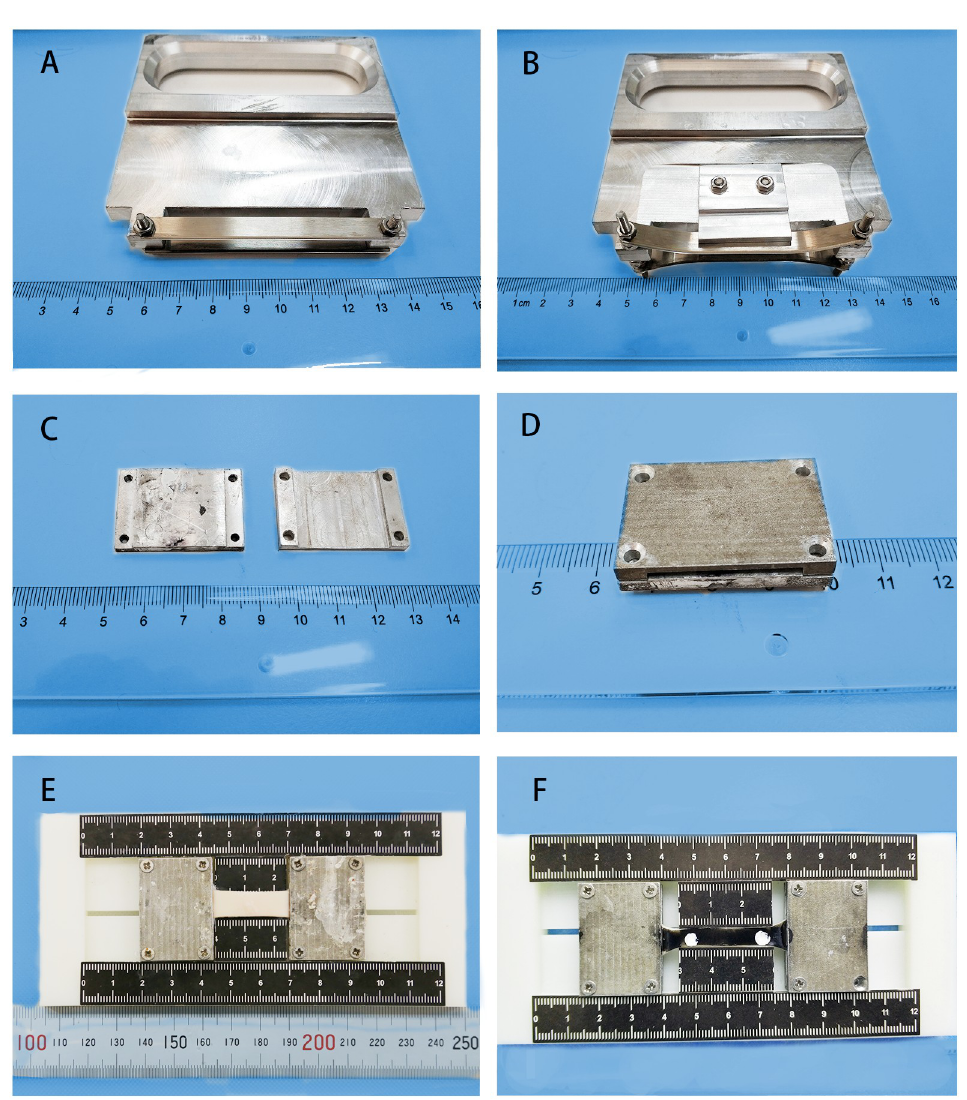
Fig 2. Custom-designed cutters, clamps and molds used for specimen processing. (A) Customized cutter for rectangular sample with a 10 mm width. (B) Customized cutter for dog-bone-shaped samples with a 6 mm width. (C) Open state of the customized clamp. (D) Closed state of the customized clamp. (E) Processed RC 8 , for which the aspect ratio is 3:1. (F) Processed DC 6 , for which the aspect ratio of the test zone is 4:1. Water-proof black ink was applied to the inner side of the samples after the strips were clamped. Two white paint spots, which were spaced 4 times the width apart at the center of the narrow zone of the specimens, were tracked by the video extensometer to identify the original length L and displacement of the test area (Fig 2F). If the samples were directly marked, it was 0 difficult to recognize by the video extensometer because the color contrast was not obvious. An Instron 5967 machine was used to perform the uniaxial tests. At the initial point, the distance between the two markers was the original length, L . The applied force and corre- 0 sponding displacement of the markers were collected synchronously and continuously at a sampling rate of 100 Hz. The other experimental procedures were consistent with the previous one.